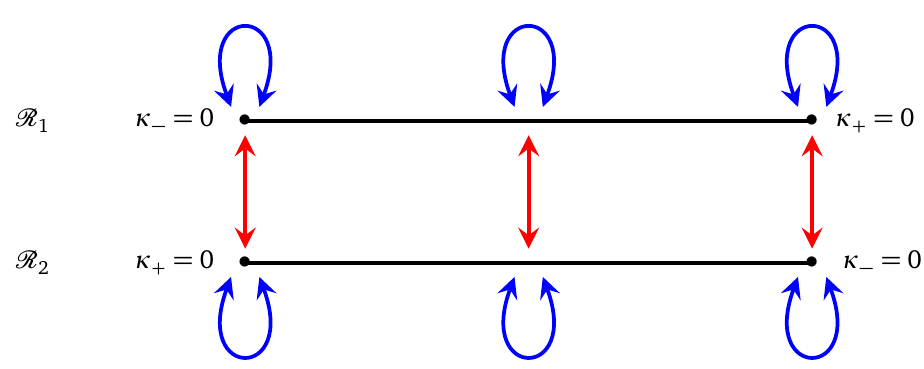
Figure 1 . The two supergravity backgrounds. The top and bottom lines represent the solu- tions corresponding to the R-matrices R 1 and R 2 respectively. At the four end-points, one of the deformation parameters, (cid:20) + or (cid:20) (cid:0) , is set to zero. The backgrounds are left invariant under the rede(cid:12)nition (3.13) (blue arrows), while the transformation (3.14) swaps the two solutions (red